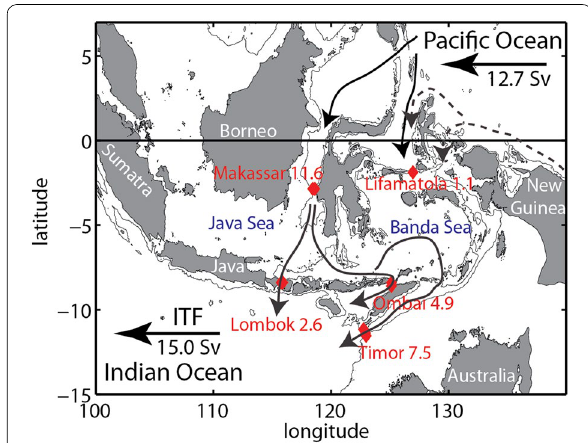
Fig. 1 Transport of the currents contributing to the Indonesian Throughflow via different passages. Transport of the currents con- tributing to the Indonesian Throughflow (ITF) via different passages through the Indonesian archipelago (after Wikipedia with transport values from Sprintall et al. 2009). Numbers next to current arrows indicate transport in Sverdrups